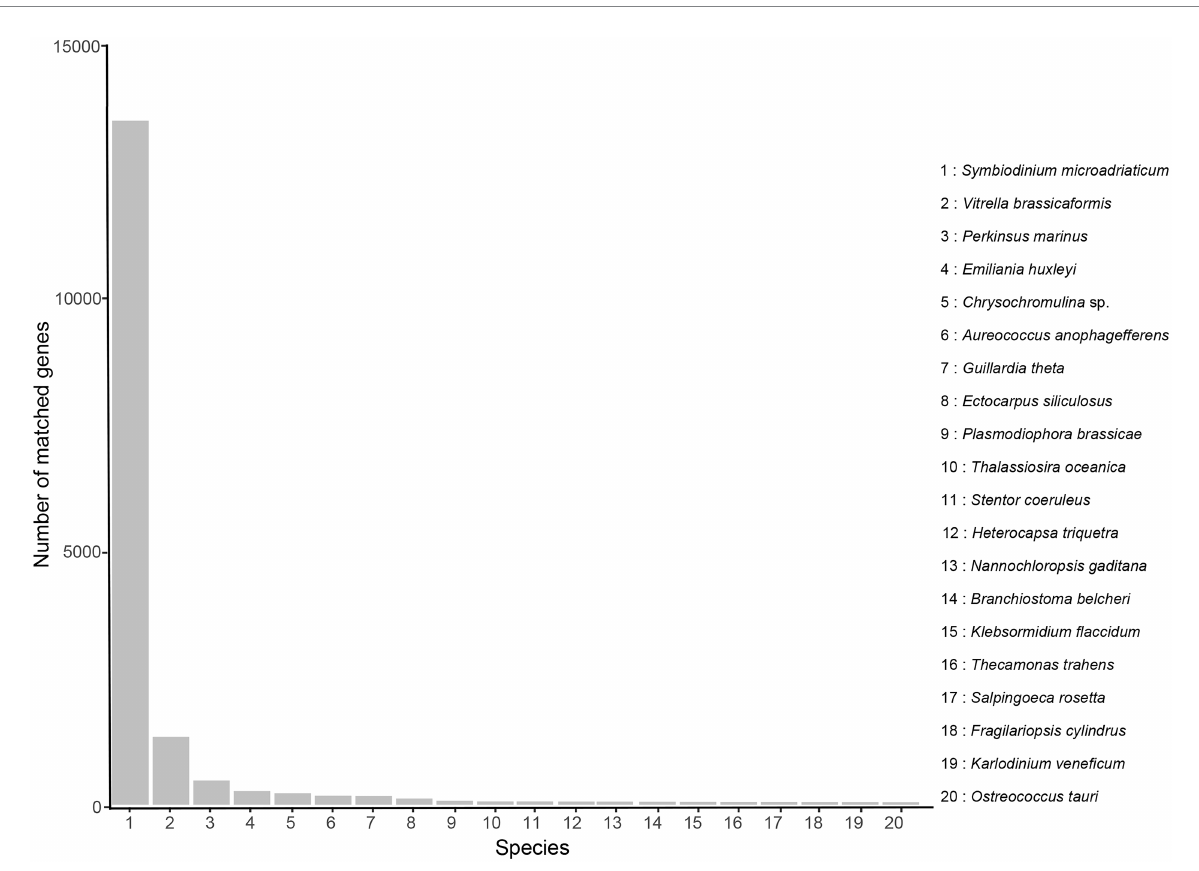
FIGURE 3 Nr classification of high-quality transcripts of the A. sanguinea full-length